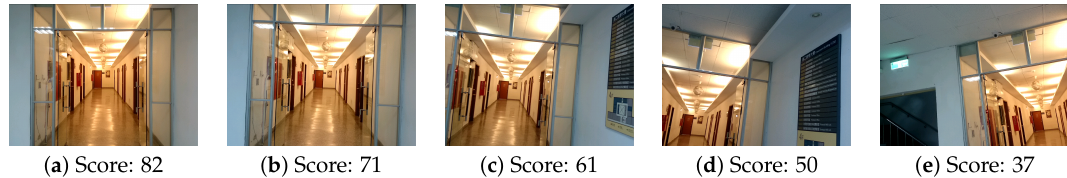
Figure 34. The scores for the second scene using the composition methods of horizontal, vanishing point, frame within a frame, and focus.